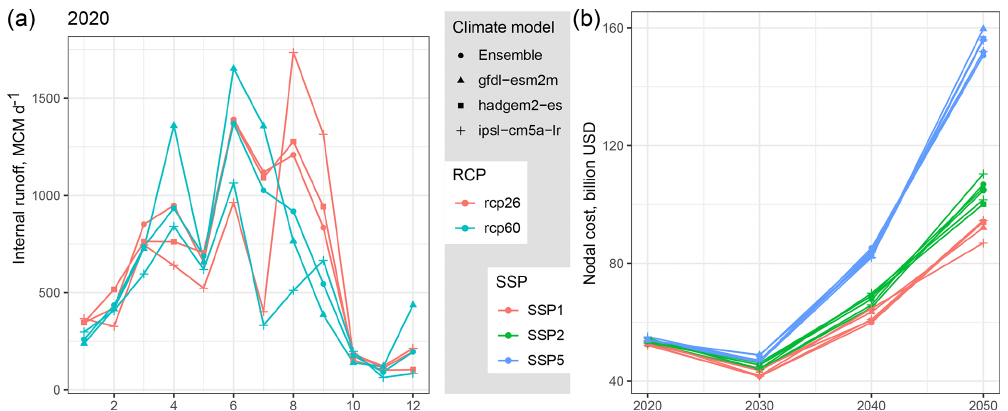
Figure 13. Total monthly runoff availability in 2020 under different RCP and climate models (a) . Total costs under different climate model, RCP and SSP assumptions (b) .